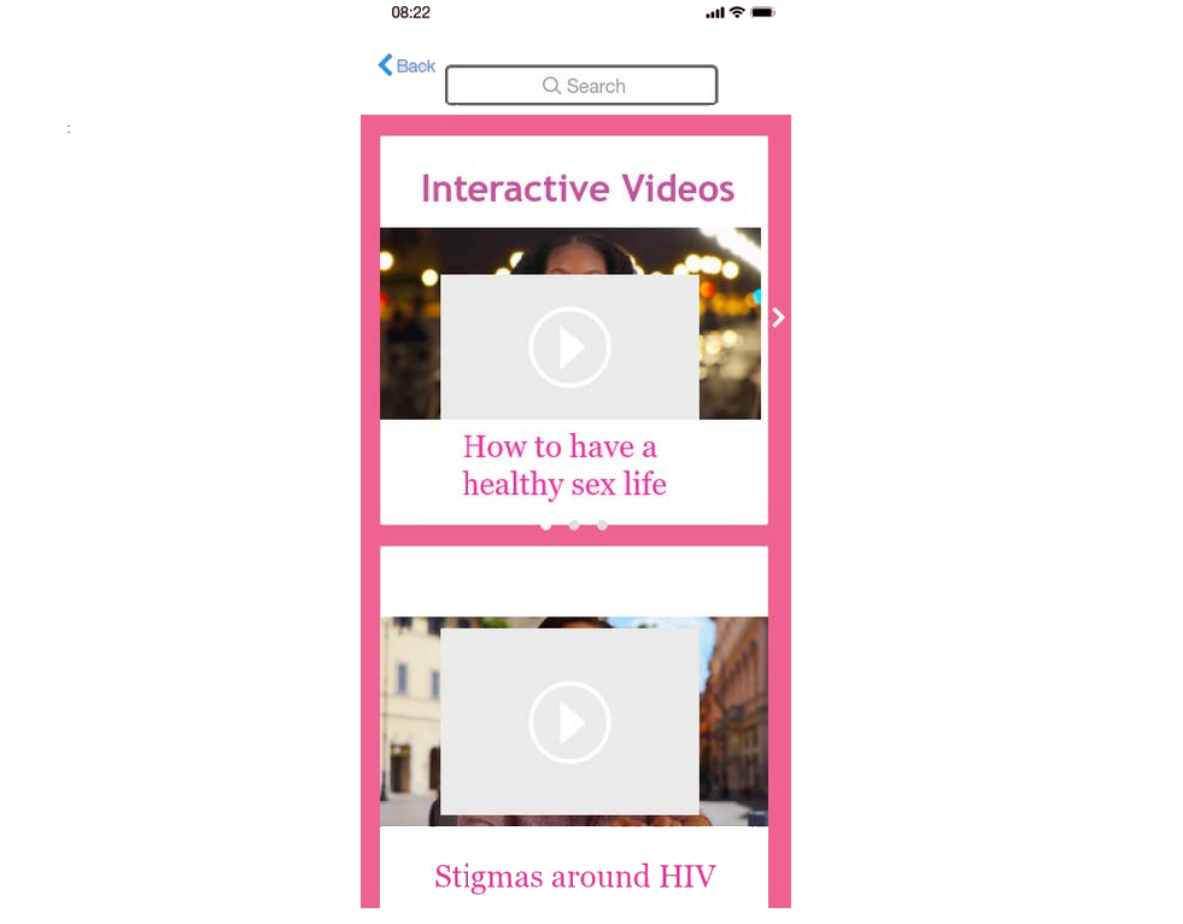
Figure 3. Interactive videos on the mobile app featuring Black